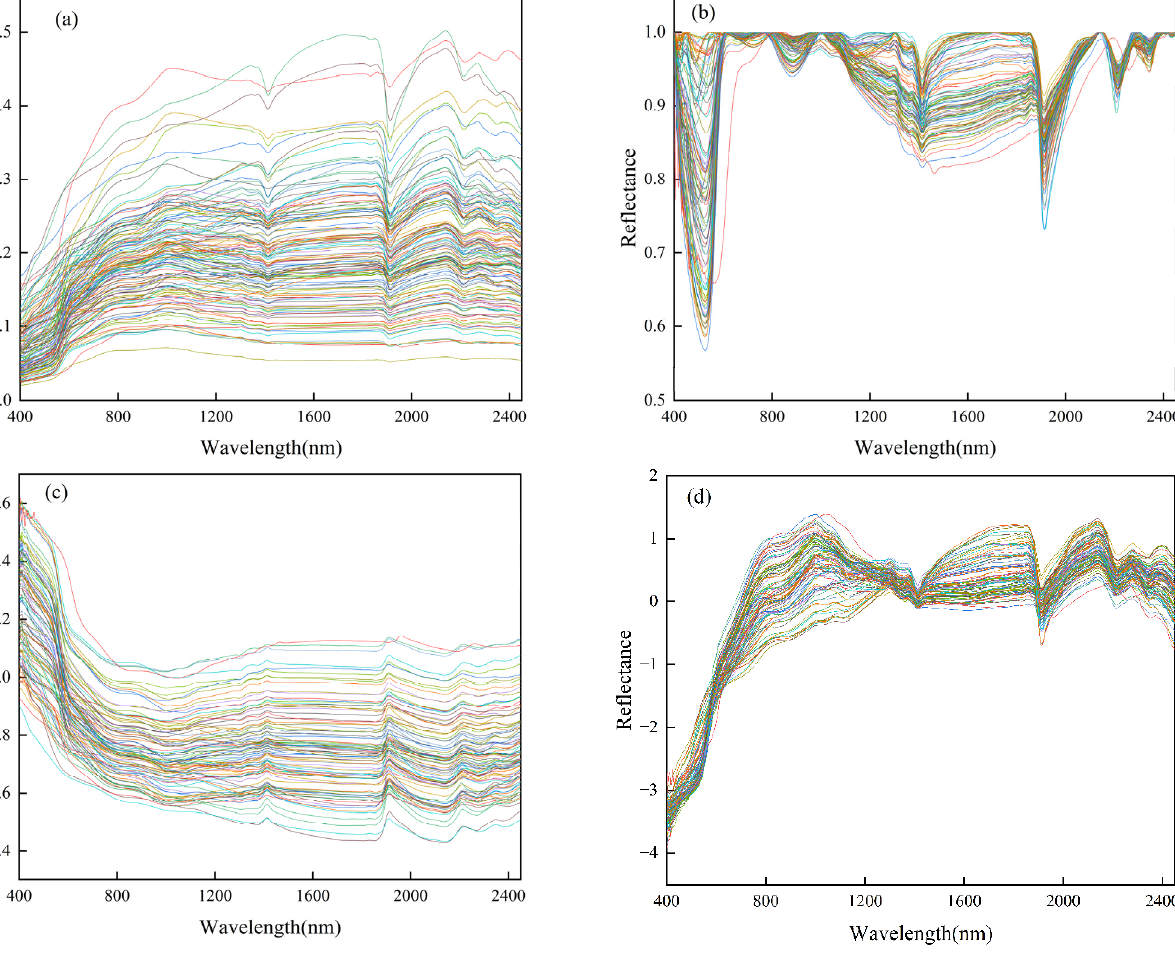
Figure 3. Transformed spectra of the soil samples: ( a ) original spectra. ( b ) continuum removal. ( c ) absorbance. ( d ) SNV transformed reflectance.